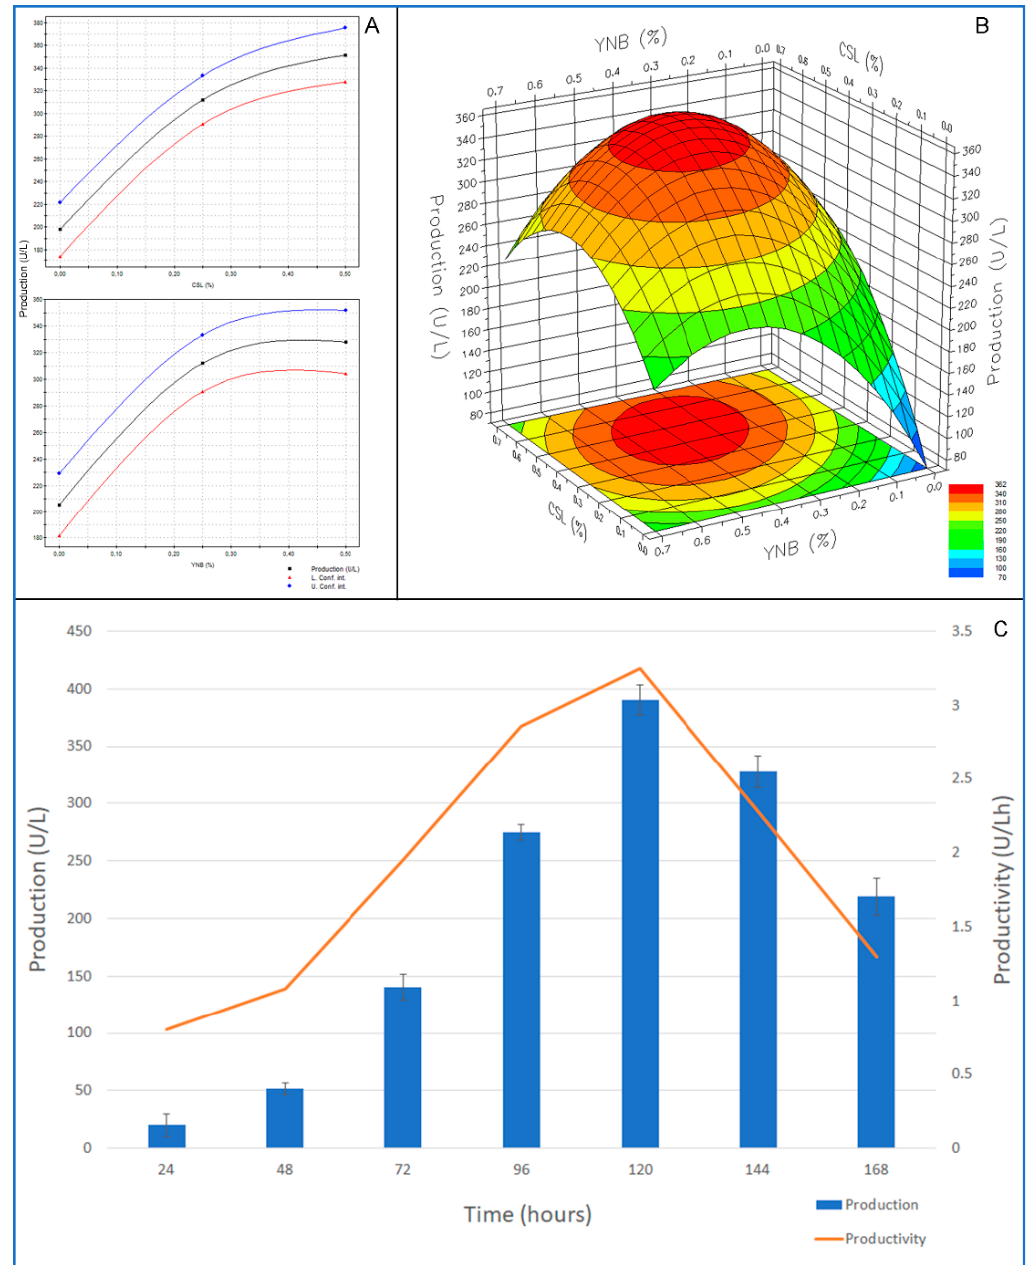
Figure 3. Single ( A ) and combined ( B ) effects of different Corn Steep Liquor (CSL) and Yeast Nitrogen Base (YNB) concentrations on the chitinolytic enzyme production by Clonostachys rosea IG119 as reported by the model. Time course of enzyme production and productivity by Clonostachys rosea IG119 cultivated on the optimized medium suggested by the Response Surface Methodology (RSM)